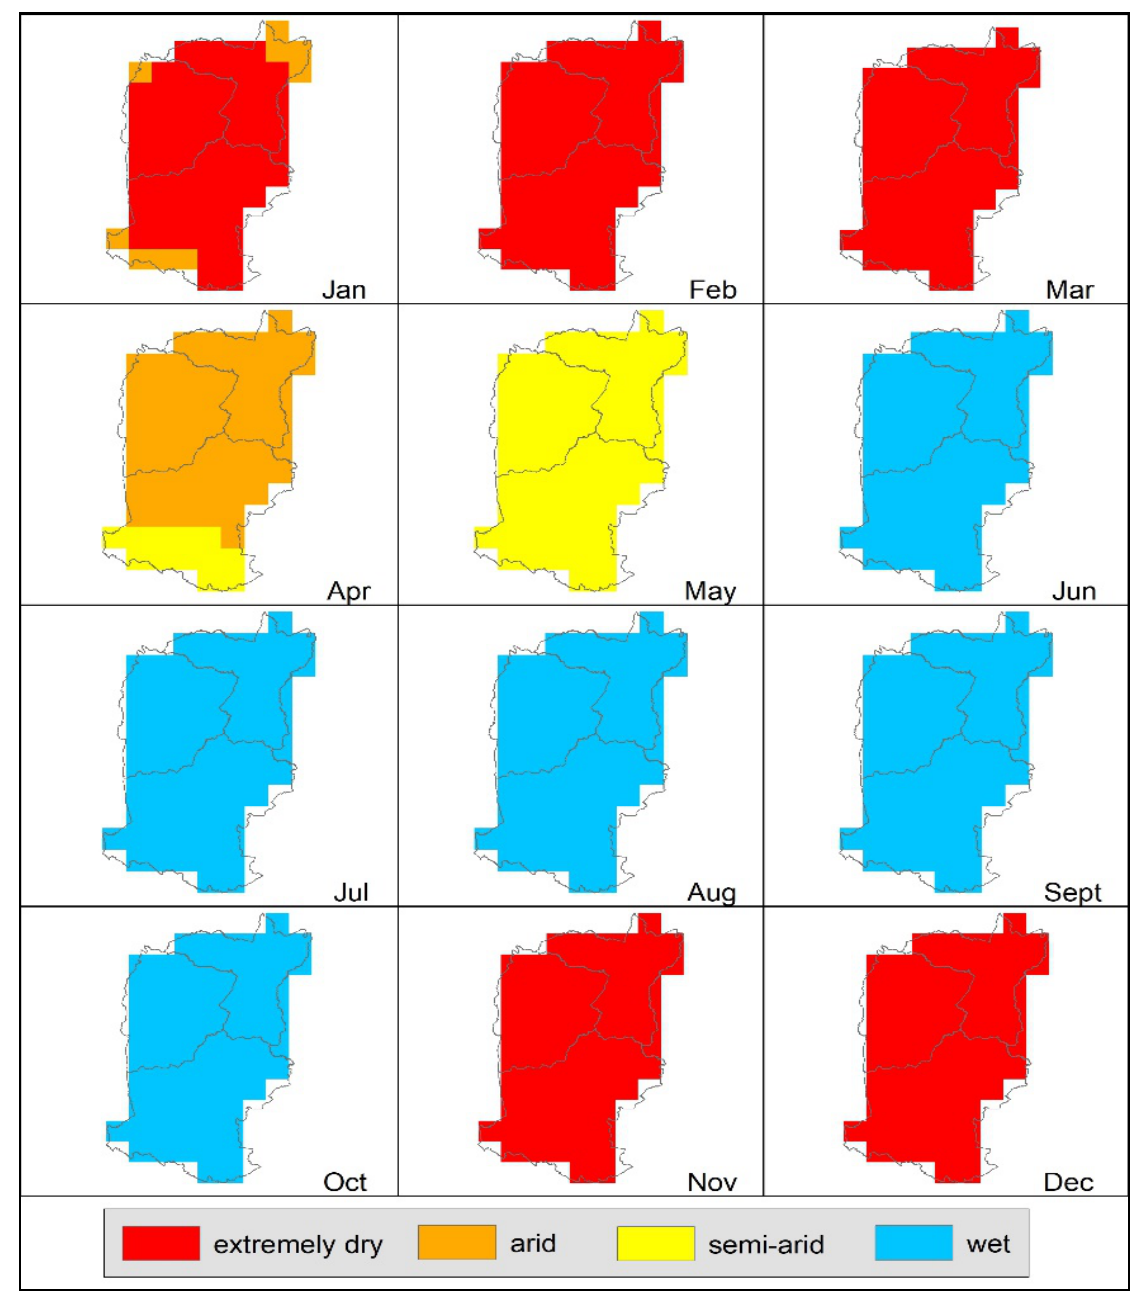
Figure 7. Thornthwaite aridity index map for 2010.